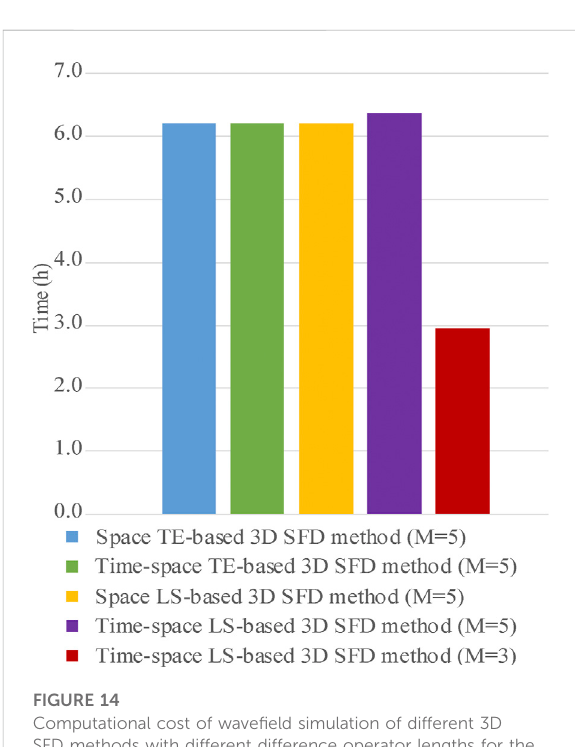
FIGURE 14 Computational cost of wave fi eld simulation of different 3D SFD methods with different difference operator lengths for the simple 3D homogeneous acoustic model (Model